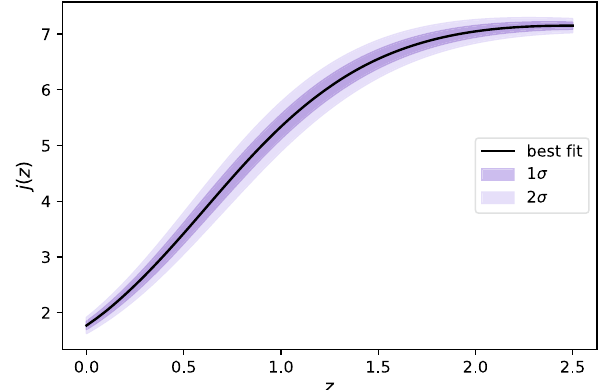
Fig. 9 The deceleration parameter q ( z ) plot for Model I I I using the best fit values and the associated 1 σ , 2 σ confidence regions from the combined analysis